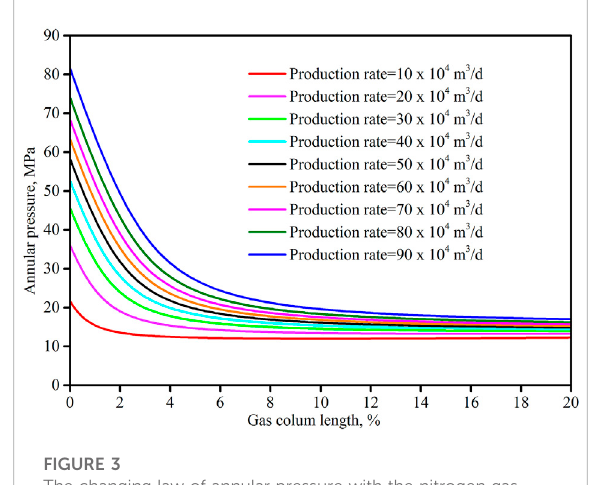
FIGURE 1 The temperature pro fi les of the production string under different pressures.